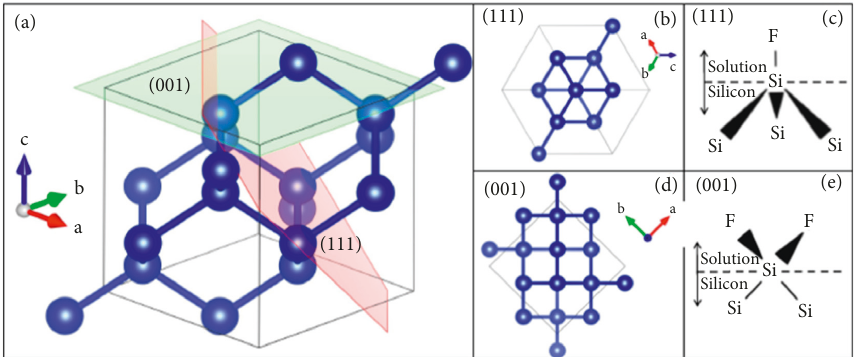
Figure 6: (a) The crystalline unit cell of silicon and the (001) and (111) planes. Crystalline cell since (b) (111) and (d) (001) planes. (c), (e) are a molecular schematic of interface solution/Si for (111) and (001) planes, respectively [71], under the terms of the creative commons CC BY